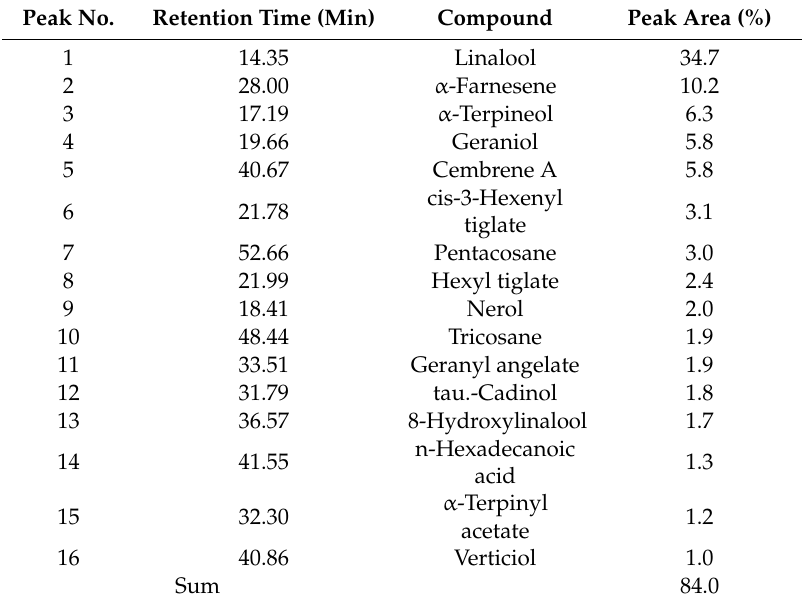
Figure 1. Total ion gas chromatogram of Gardenia jasminoides essential oil. Peaks: (1) Linalool; (2) α -farnesene; (3) α -terpineol; (4) geraniol; (5) cembrene A; (6) cis-3-hexenyl tiglate; (7) pentacosane; (8) hexyl tiglate; (9) nerol; (10) tricosane; (11) geranyl angelate; (12) tau.-cadinol; (13) 8-hydroxylinalool; (14) n-hexadecanoic acid; (15) α -terpinyl acetate; (16) verticiol. Table 1. Main constituents of G. jasminoides essential oil (GEO).